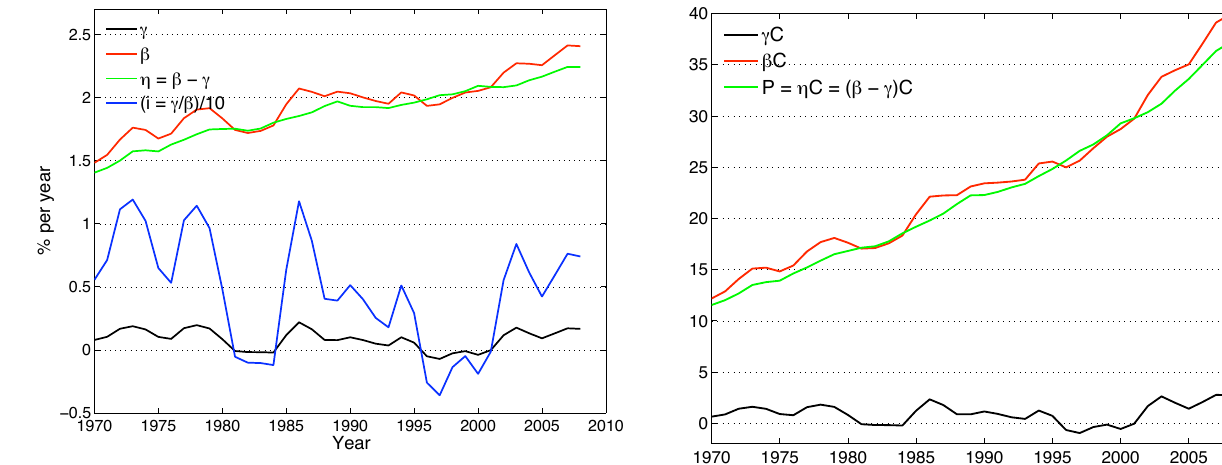
Fig. 2. From global economic statistics (United Nations, 2010), derived global values for global inflation i (Eq. 25), the decay coefficient γ (Eq. 21), the source coefficient β (Eq. 22) and the rate of return η (Eq. 24) based on observations of nominal and real production, and total global wealth.